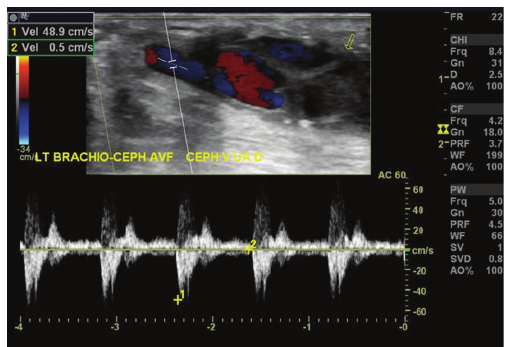
Figure 6: This brachiocephalic fistula has thrombosed. Waveforms demonstrate a to-and-from characteristic indicative of a vessel with no outflow. Low PSV, the absence of color flow throughout the access, and the presence of echogenic material within the fistula are other findings compatible with access thrombosis.